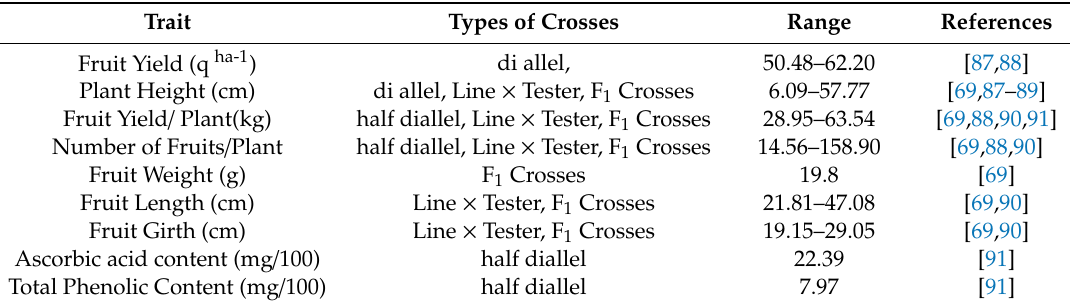
Table 2. Heterosis in cultivated eggplant for important morphological and fruit biochemical traits. Trait Types of